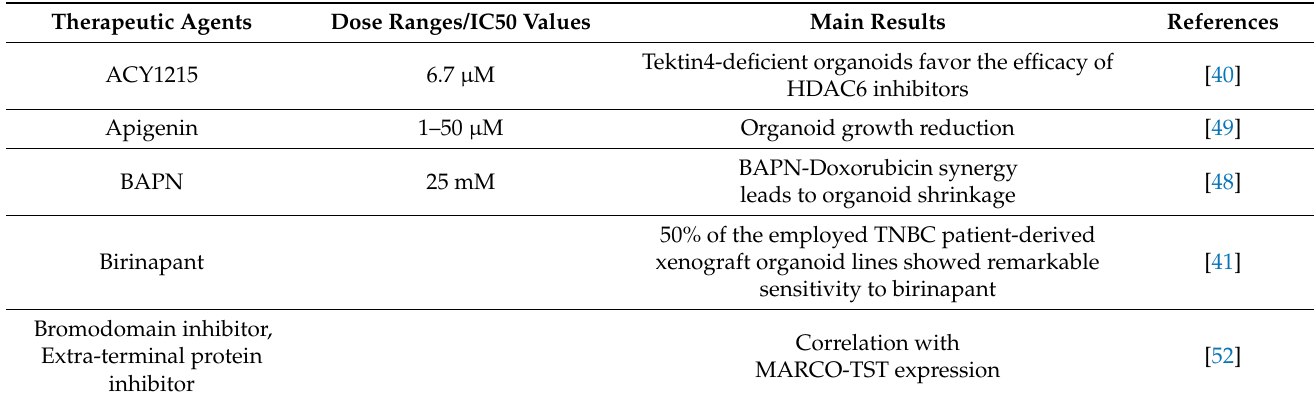
Table 2. The use of organoids for alternative and targeted therapy sensitivity testing in